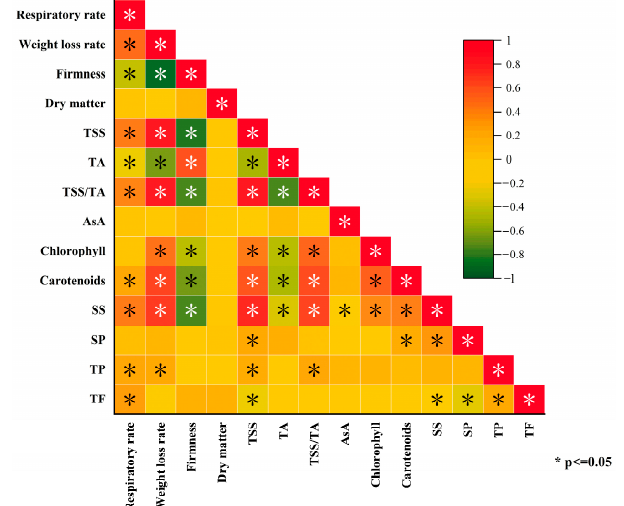
Figure 5. Correlation analysis of quality of kiwifruit under room-temperature storage. Note: * represents a significant difference between p ≤ 0.05. Table 4. Rotated component matrix of principal component analysis.